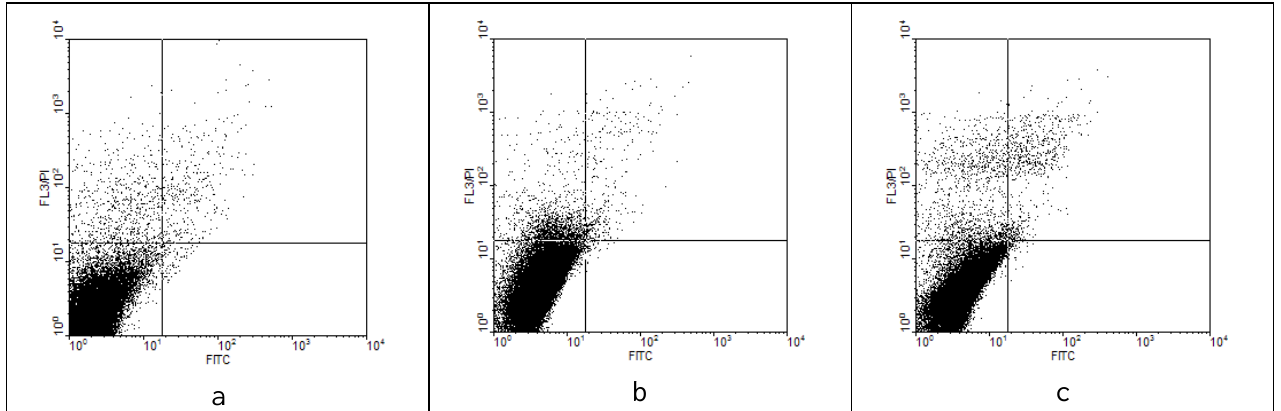
Figure 2. Flow cytometry dot-plots of effects on HeLa cells: a) Control; b) 5g ; c) 5h